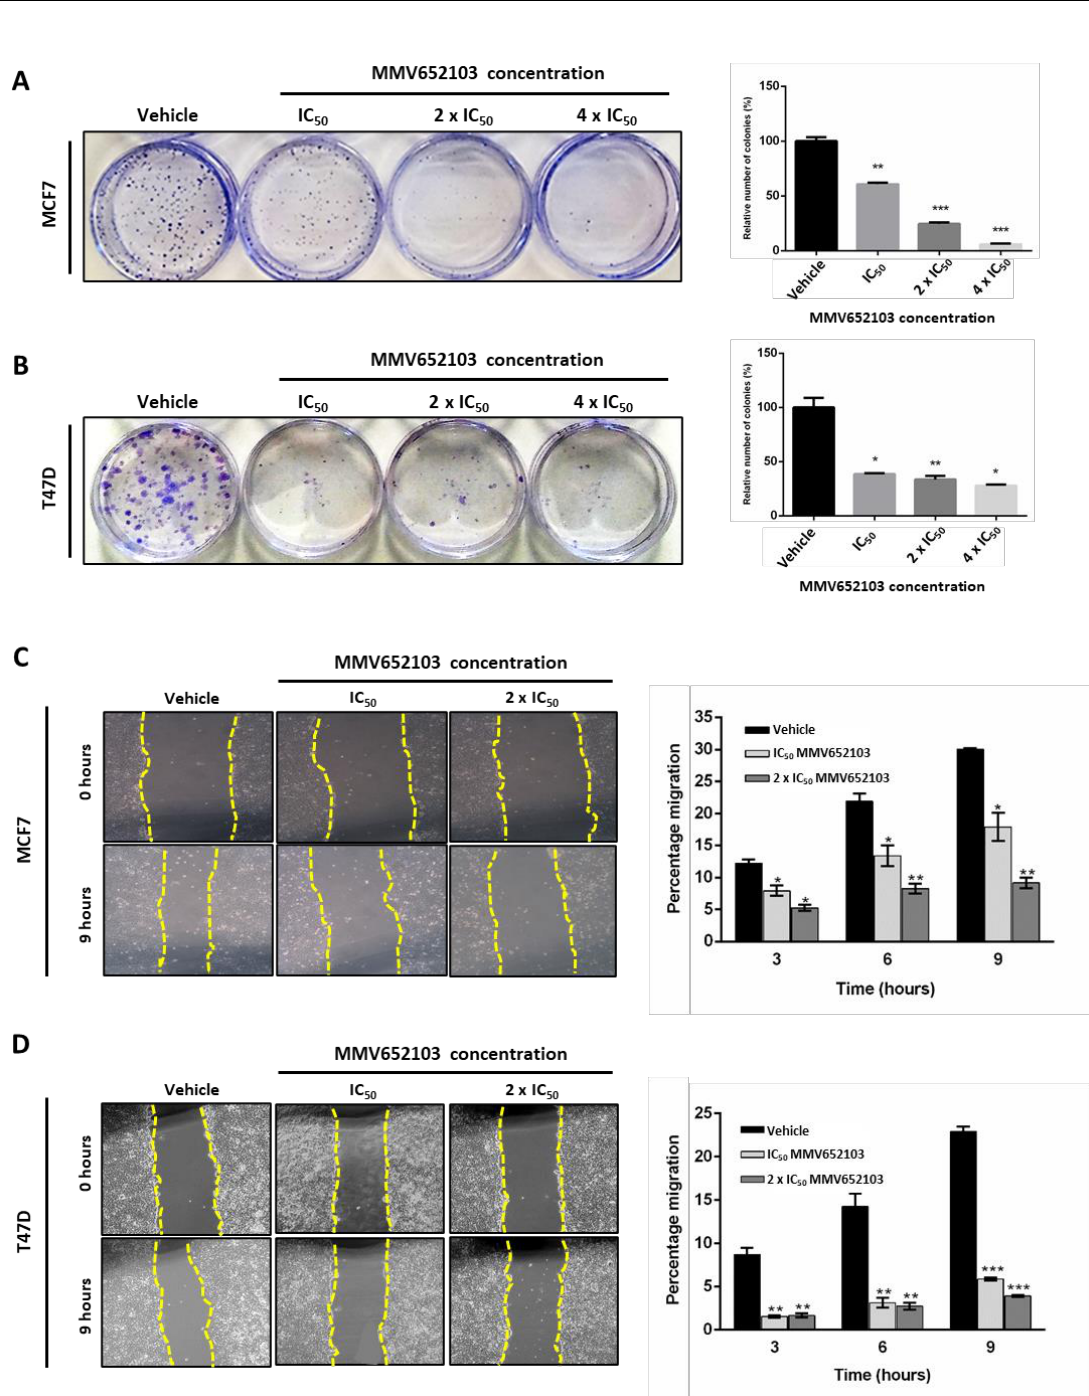
Figure 3: MMV652103 inhibits long-term survival and migration of MCF7 and T47D ER+ breast cancer cells in vitro . Representative images and quantification of clonogenic assays of ( A ) MCF7 and ( B ) T47D cells which were treated with vehicle (DMSO), IC 50 , 2 x IC 50 and 4 x IC 50 MMV652103 for 24 h. Colonies were stained with crystal violet and images from three independent experiments were quan- tified using ImageJ. The graphs represent the relative number of colonies in percentage (relative to the vehicle control). Quantification and representative images (×200; EVOS XL AMEX1000 Core Imaging System) of scratch motility assays of ( C ) MCF7 and ( D ) T47D cells treated with IC 50 and 2 x IC 50 con- centrations of MMV652103 or vehicle for 9 h. Cells were imaged at 0, 3, 6, and 9 h post wound formation. Total area migrated was calculated by subtracting the wound area at each time point from the wound area at time 0 h, which is represented in the graphs as mean area migrated ± SEM pooled from three independent experiments. Data were analyzed using GraphPad Prism 6.0 and a parametric unpaired t- test was performed where *p < 0.05, **p < 0.01, ***p <